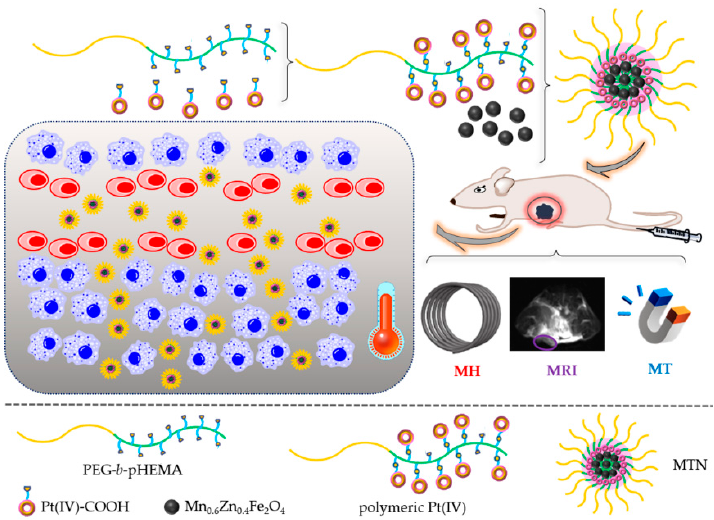
Figure 1. Schematic illustration of the theranostic nanocomplex formation and its cascading effects on diagnosis and therapy of tumors, including efficient magnetic targeting firstly, following magnetic resonance imaging, subsequent magnetic hyperthermia to promote penetration of nanocomplex, and enhanced antitumor efficiency of polymeric Pt(IV) finally.